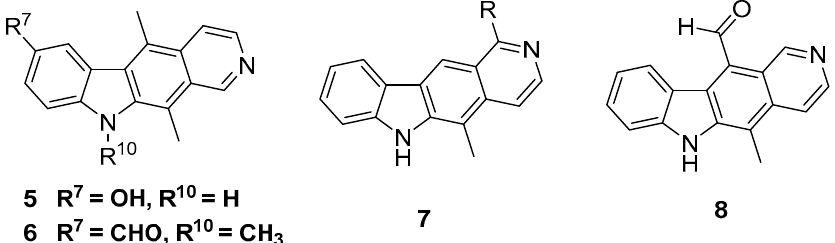
Figure 2. Substituted isoellipticines ( 5 and 6 ) with in vivo activity, Olivacine 7 and 11-formylellipticine